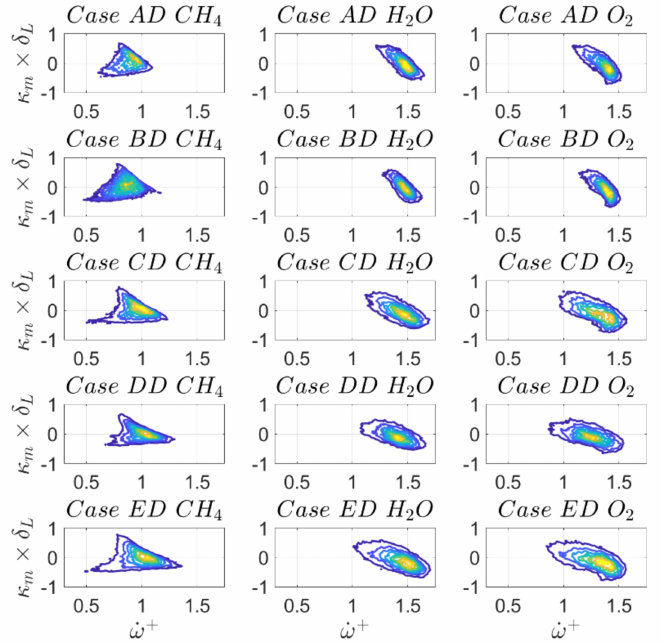
Figure A1. Joint PDF of normalised, reaction rate (1st to 3rd column CH 4 , H 2 O,O 2 ) and normalised mean curvature κ m × δ L . All results are shown for c = 0.8 isosurface based on O 2 mass fraction, for top to bottom cases AD–ED.